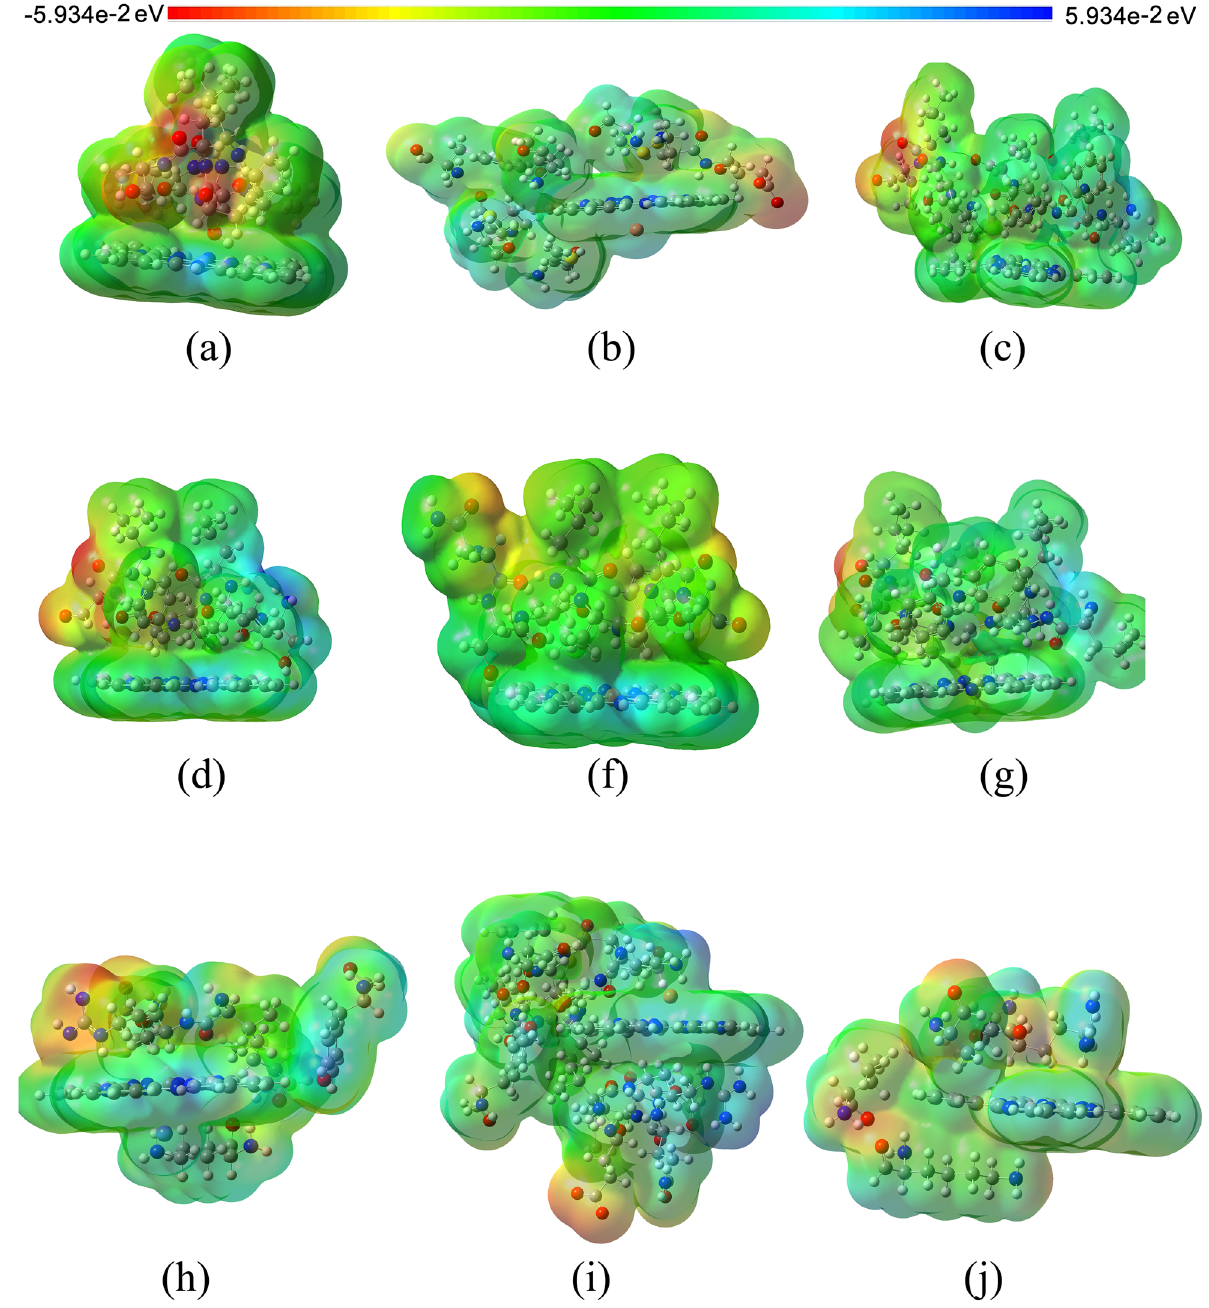
Figure 7. The MESP for E-pro: ( a ) CoPc, ( b ) CuPc, and ( c ) NoPc; M-pro: ( e ) CoPc, ( f ) CuPc. and ( g ) NoPc; and S-gly: ( h ) CoPc, ( i ) CuPc, and ( j ) NoPc), with B3LYP / LANL2DZ level of